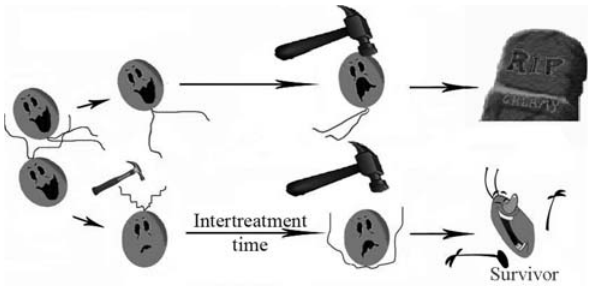
Figure 7 - Experimental design used for induction of the AR in Chlamydomonas reinhardtii as a model